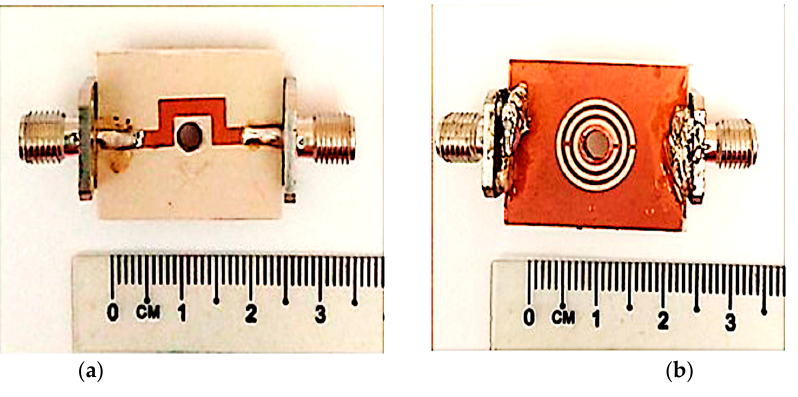
Figure 11. Fabricated prototype of triple-rings CSRR sensor. ( a ) Top and ( b ) bottom views.